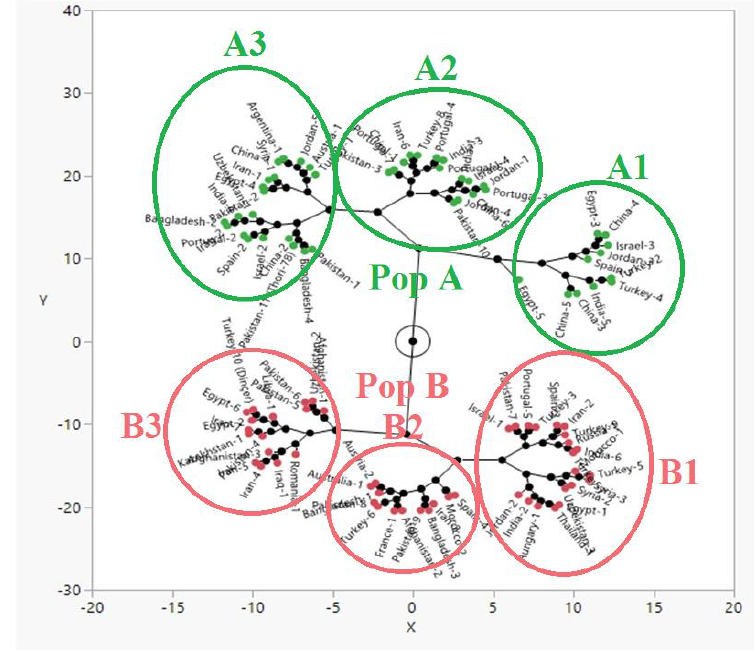
Figure 2. Constellation plot for 100-seed weight in international safflower panel.